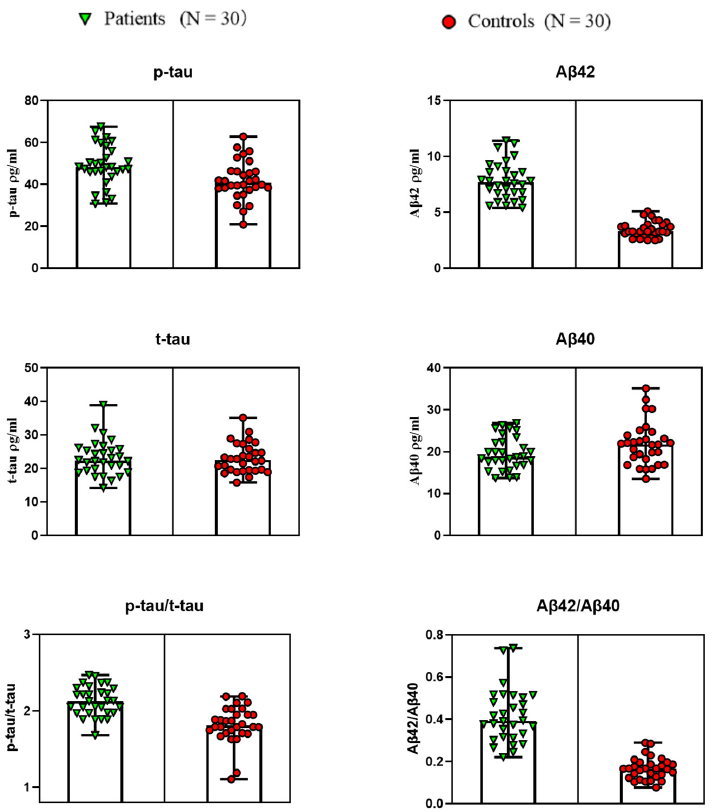
Figure 3. Salivary A β 40, A β 42, t-tau, p -tau, p -tau/t-tau, and A β 42/A β 40 in AD patients and non-AD controls. Lines represent the maximum and minimum range.